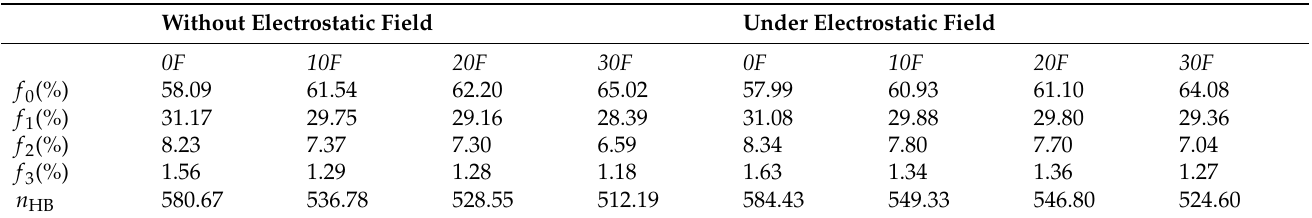
Table 4. The proportion of water molecules that have n hydrogen bonds ( f n ), the amount of Fe 2+ that was added F ( n*F ), and the average number of hydrogen bonds per water molecule ( n HB ). Without Electrostatic Field Under Electrostatic